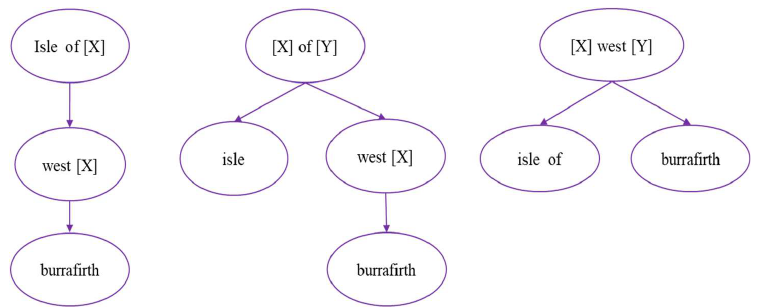
Figure 3. Schemes of lexical structure analysis of the geographical name "Isle of West Burrafirth". All three schemes satisfy established assumptions.